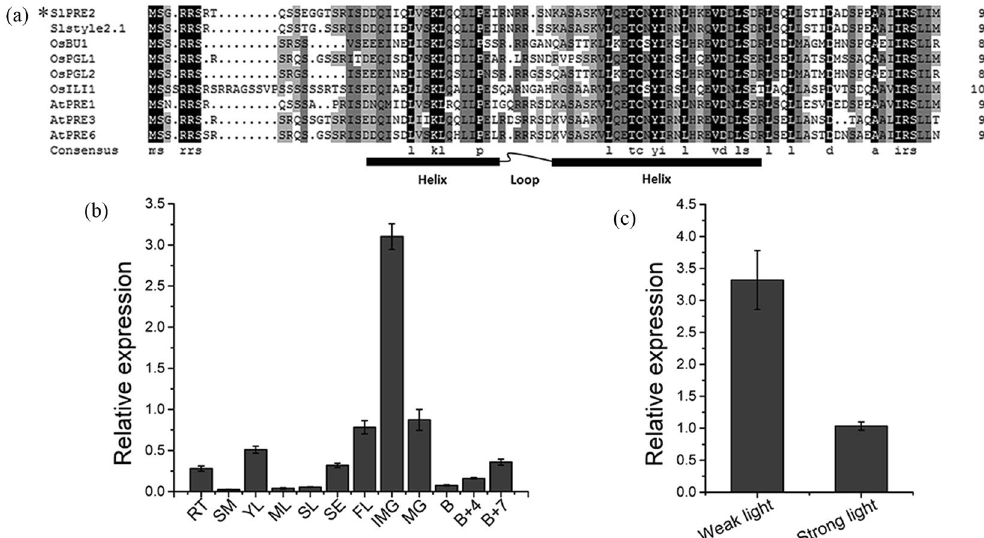
Figure 1. Multiple sequence alignment and expression profile of SlPRE2 . ( a ) Multiple sequence alignment of SlPRE2 and other bHLH proteins. The SlPRE2 and Slstyle2.1 are proteins from tomato. OsBU1, OsPGL1, OsPGL2, OsILI1 are proteins from rice. AtPRE1–6 are proteins from Arabidopsis . Black and gray backgrounds indicate identical and similar amino acids. Convergence in structure is indicated by black box and curve. ( b ) The relative expression patterns of SlPRE2 in wild type tomato. RT, root; SM, stem; YL, young leaf; ML, mature leaf; SL, senescent leaf; SE, sepal; FL, flower; IMG, immature green fruit; MG, mature fruit; B, breaker fruit; B + 4, 4 days after breaker stage; B + 7, 7 days after breaker stage. ( c ) The relative expression levels in weak and strong light growth condition for 8 hours. Data are the mean ± SD of three biological